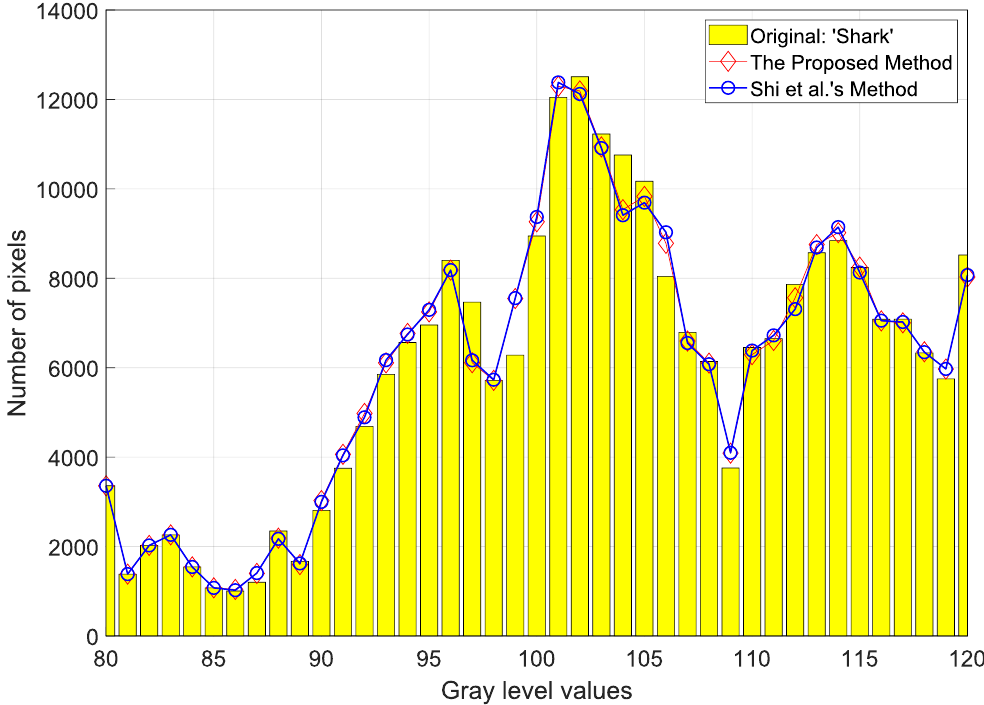
Figure 9. Comparison of histogram coefficients on depth map—“Shark” between Shi et al.’s method and the proposed